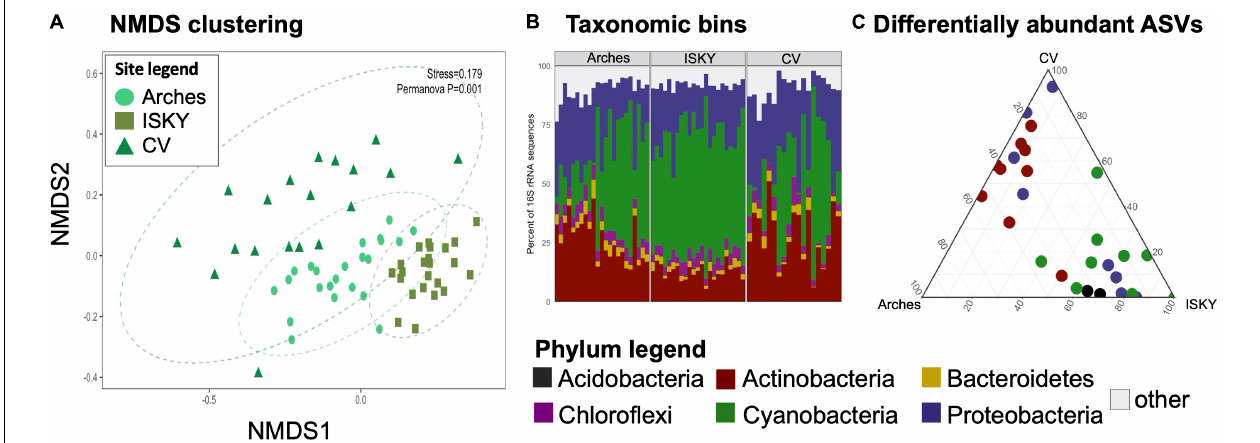
FIGURE 3 | Field site biogeography. For each dataset the control samples were compared to investigate if the normal state of the soil microbiome differed among sites. (A) NMDS clustering. The stress value of the ordination is indicated. Ellipses indicate the 95% confidence interval of the group centroids. PERMANOVA statistical testing identified field site as a significant factor in discriminating the bacterial communities ( P = 0.001). (B) Phylum level taxonomic bins in the datasets. Stacked bar graphs representing the relative abundance of the six most predominant bacterial phyla in the datasets. Each phylum accounted for at least 1% of the recovered sequences across the individual samples. The remaining taxa were assigned to the category “other.” Four phyla were identified as significantly different in relative abundance between sites, Actinobacteria, Bacteroidetes, Cyanobacteria, and Proteobacteria. (C) Ternary diagram of differentially abundant ASVs. Each point represents an ASV identified as significantly different in relative abundance among the sites. Points are colored by the Phylum to which they belong. A full list of the differentially abundant ASVs are listed in Supplementary Table 1